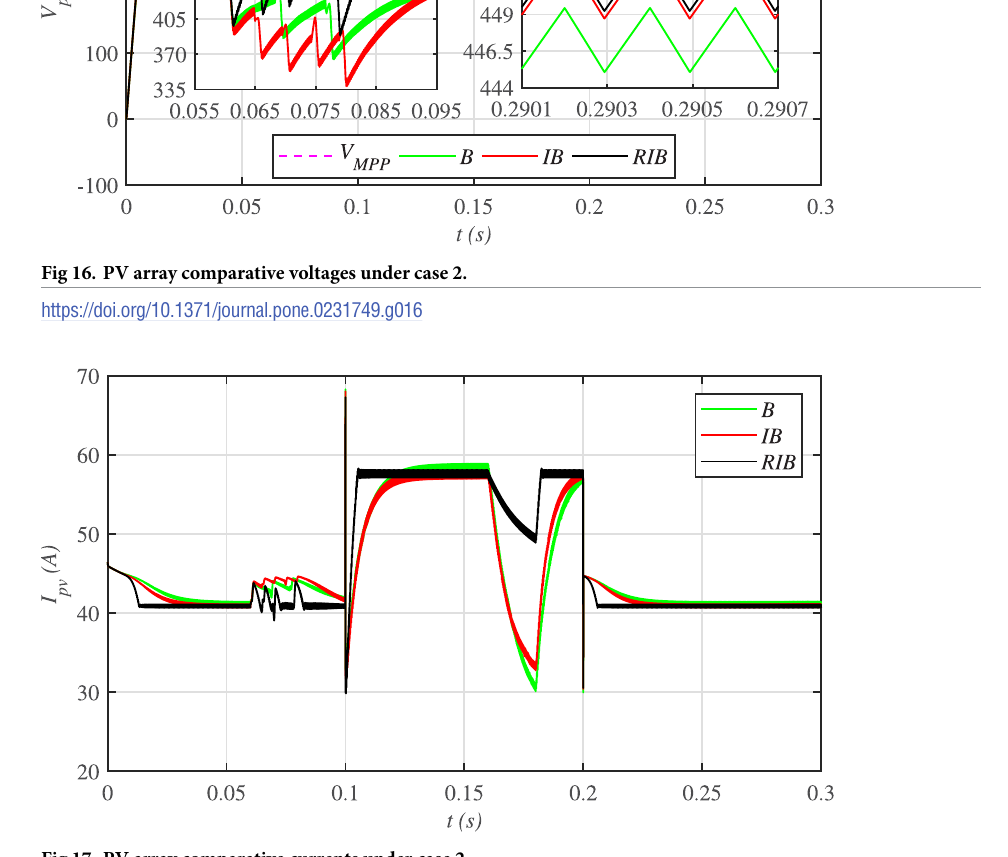
Fig 17. PV array comparative currents under case